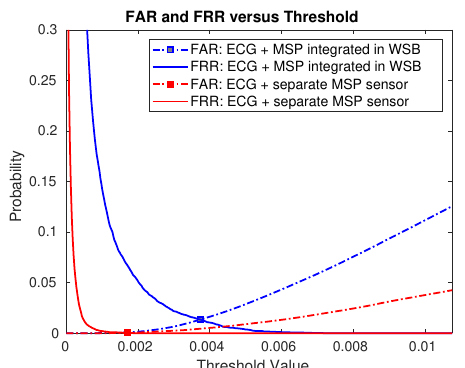
Figure 12. False Acceptance Rate ( FAR ) and False Rejection Rate ( FRR ) graphs for different threshold values for proposed multimodal biometrics methods: ECG + MSP integrated in Wearable Security Band (WSB); and ECG and MSP separately measured for better contact (ECG + separate MSP sensor),